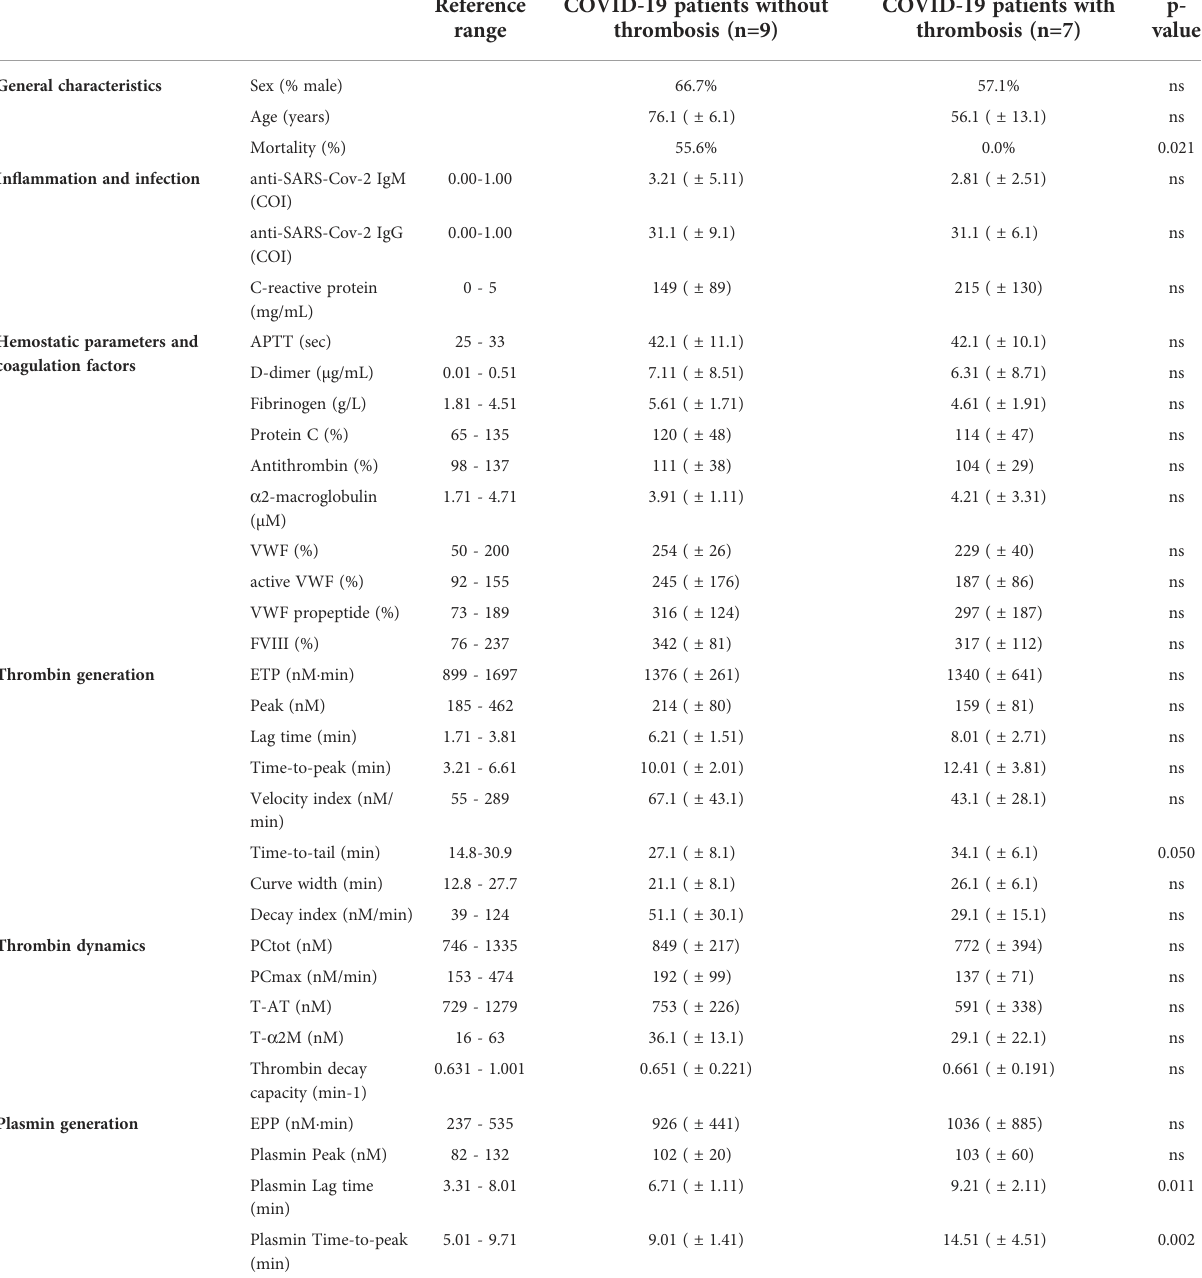
TABLE 2 General characteristics and laboratory tests of the intensive care unit patient (n=16) cohort